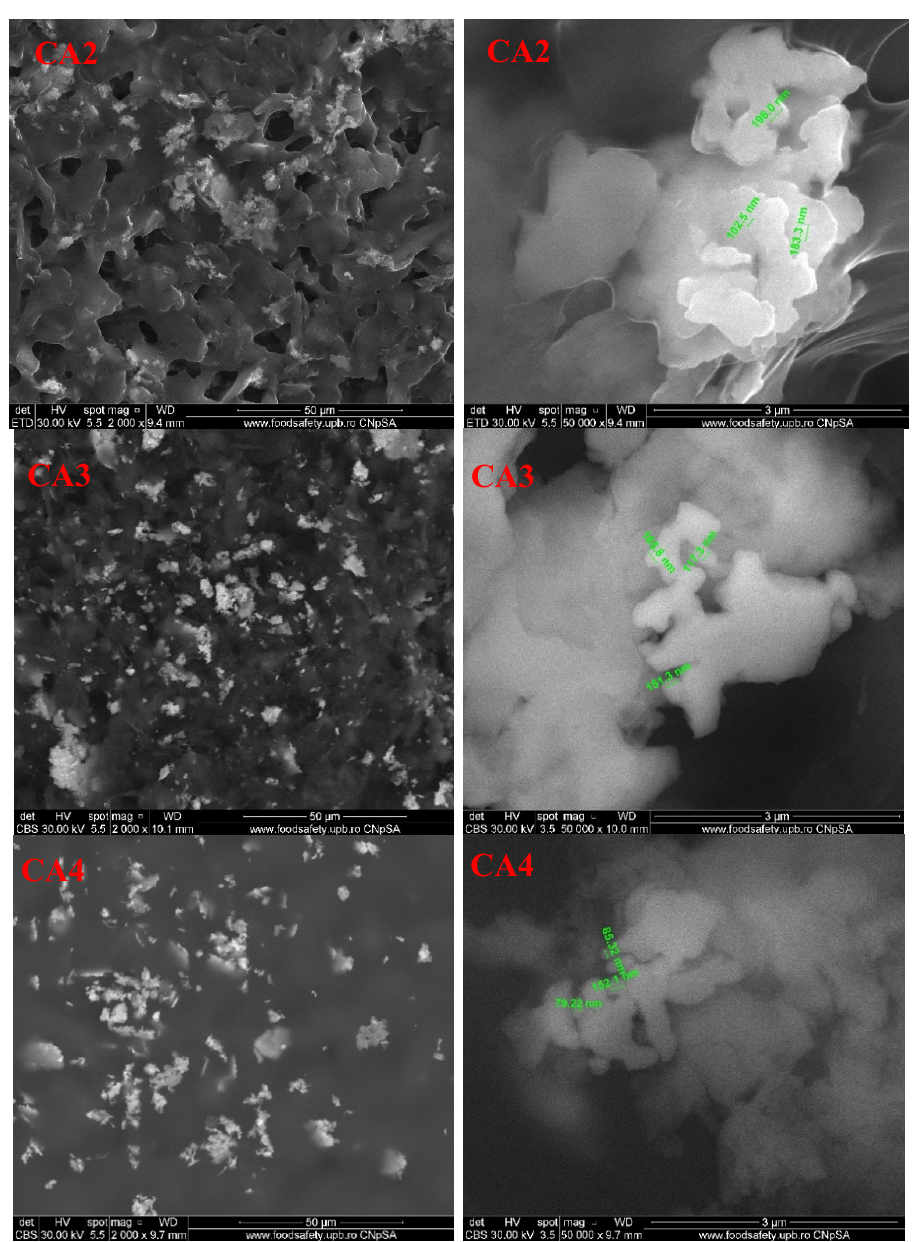
Figure 12. The SEM images for chitosan, CA1, CA2, CA3, and CA4 films.